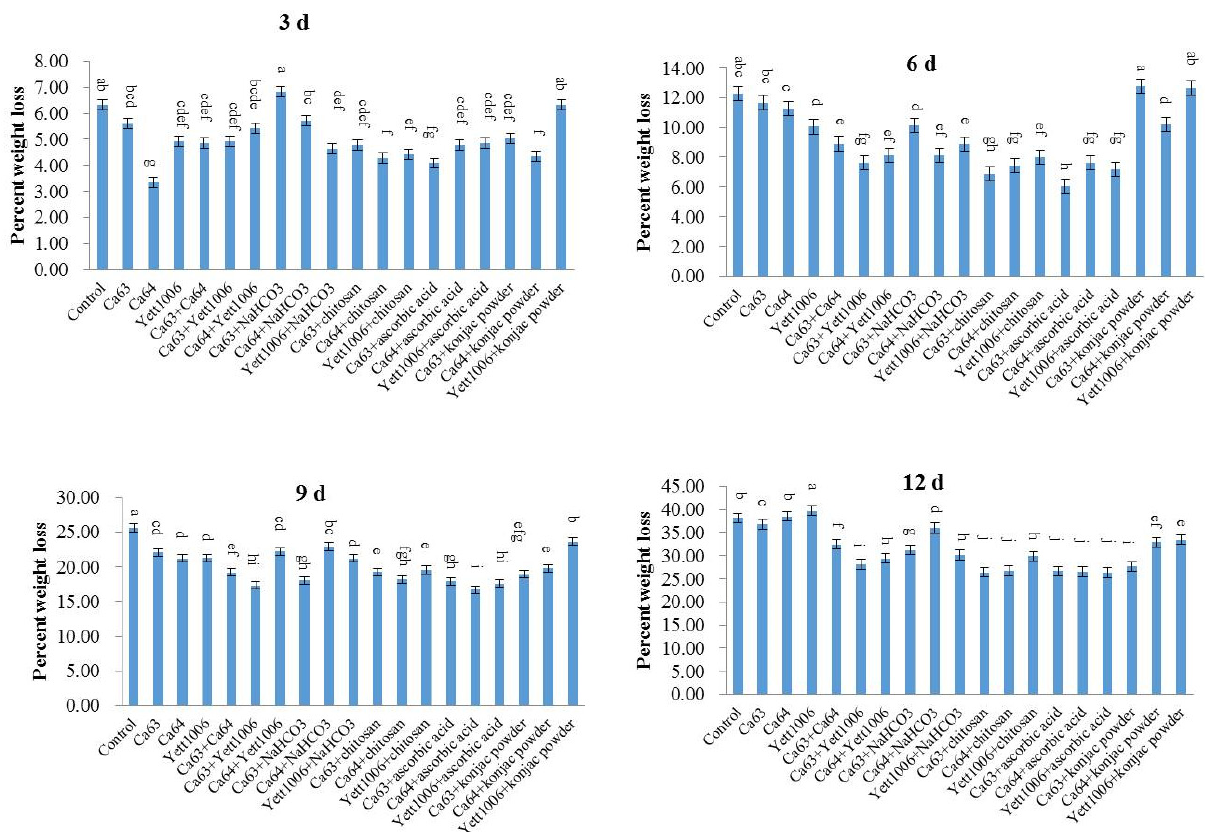
Figure 5. Evaluation of weight loss in snap beans between different treatments. Error bars represent the standard deviations of means ( n = 3). On the bars, the small letters indicate a significant difference in the treatment according to Duncan’s multiple difference test ( p < 0.05).